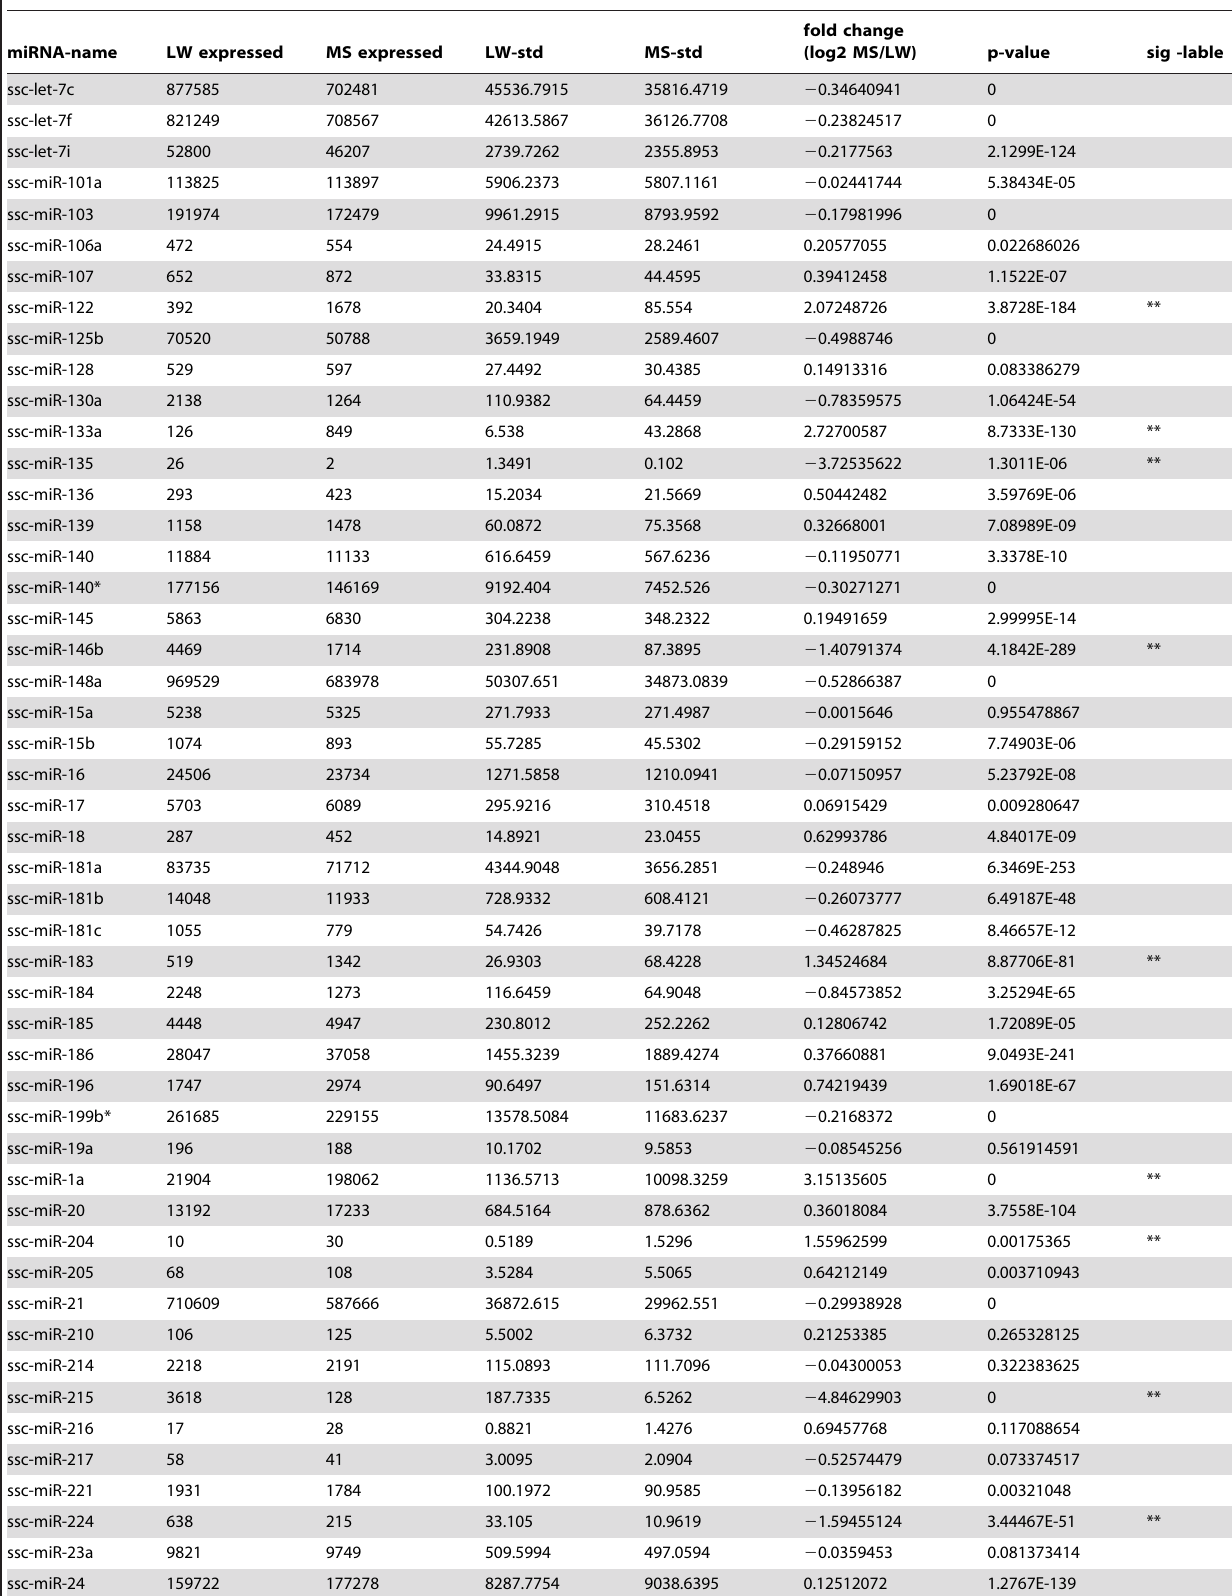
Table 1. The expression profile of all known miRNAs in Large White and Meishan small RNA